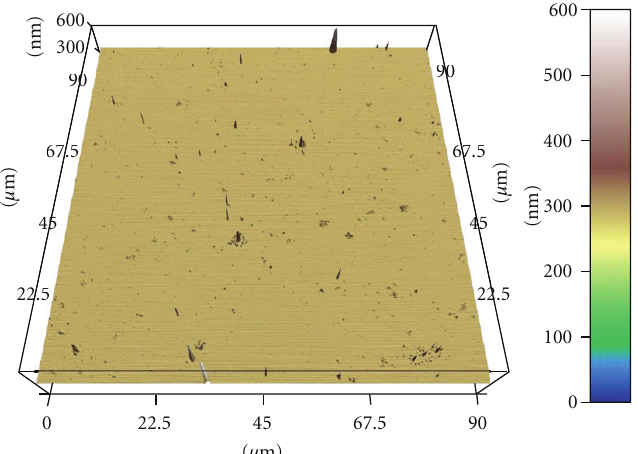
Figure 1: Example of an AFM illustration representing surface roughness (C = hexylated polymer spin coated with amorphous silicon dioxide).